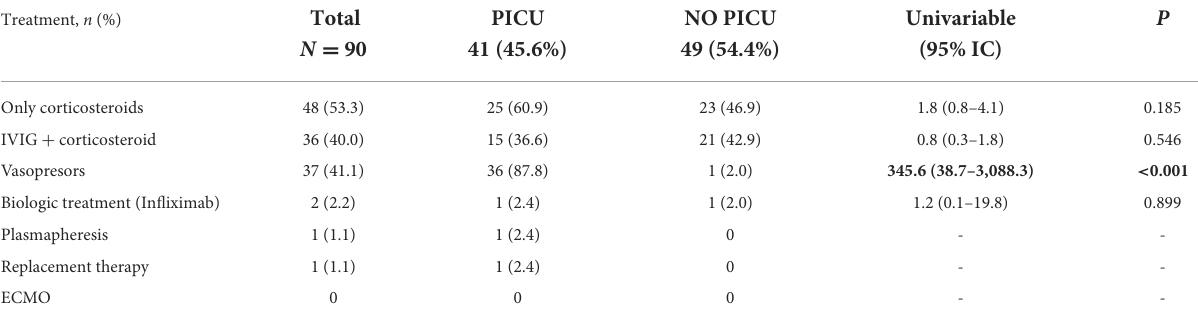
TABLE 2 Management of 90 patients with Multisystem Inflammatory Syndrome in Children in Hospital Infantil de México Federico Gomez, by PICU admission status from March 2020 to January 2022. Treatment, n (%)